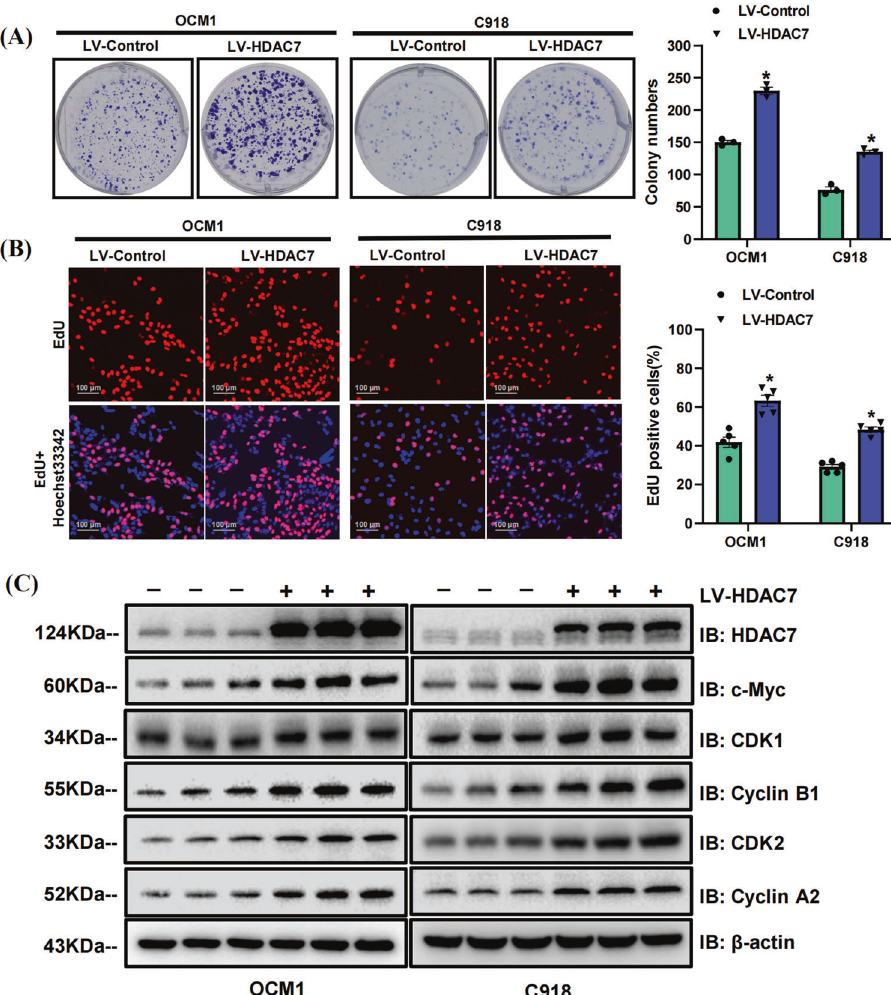
Fig. 1 HDAC7 overexpression facilitates OCM1 and C918 cell proliferation in vitro. A Typical picture and statistical analysis of the colony formation assay in LV-HDAC7 OCM1/C918 and LV-Control OCM1/C918 cells. B Typical pictures and statistical analysis of the EdU incorporation assay in LV-HDAC7 OCM1/C918 and LV-Control OCM1/C918 cells. The results were calculated as the ratio of the number of EdU-positive cells (red fl uorescence) to the total number of Hoechst 33342 stained cells (blue fl uorescence). Scale bar, 100 μ m (inset). C Typical Western blot results of HDAC7, c-Myc, CDK1, Cyclin B1, CDK2, and Cyclin A2 in LV-HDAC7 OCM1/C918 and LV-Control OCM1/C918 cells. β -actin was used as an internal control. Data are exhibited as the mean ± SD. Student ’ s t -test, * P < 0.05 vs. LV-Control group. Abbreviations: LV lentivirus,